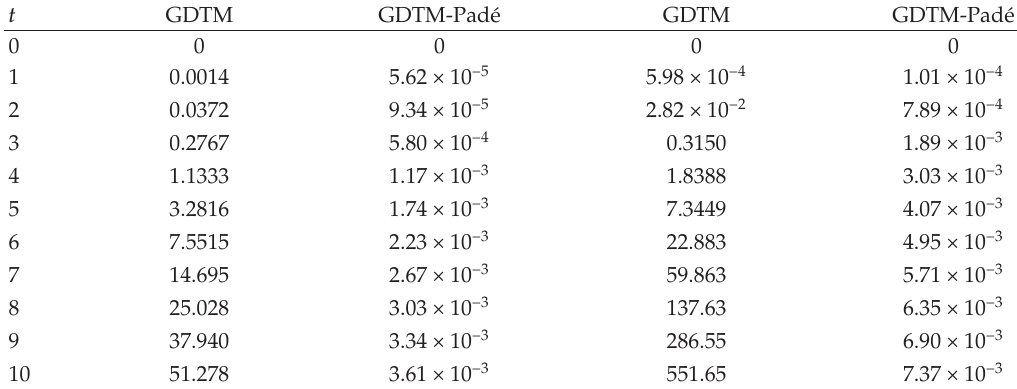
Table 3: Numerical results of the absolute errors between the GDTM solutions and the GDTM-Pad´e solutions for (cid:4) 1.2 (cid:5) with c (cid:8) 1, d (cid:8) 0 . 5 and n (cid:8)